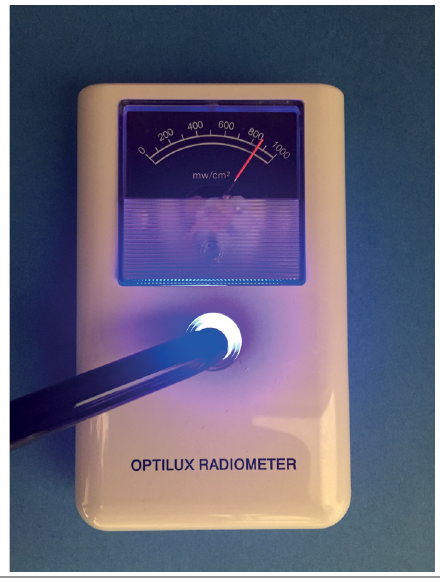
Figure 39. Evaluation of the curing light’s status with